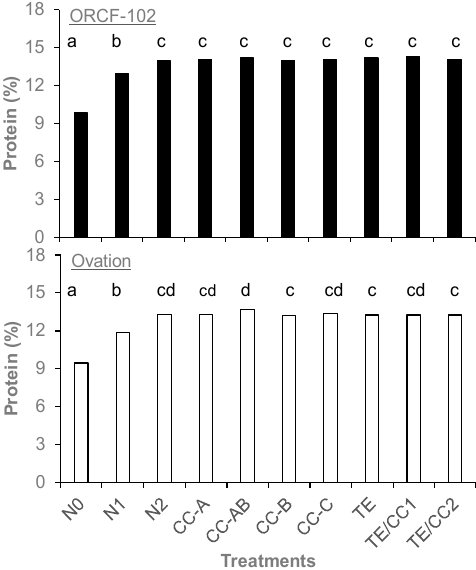
Figure 3. The protein content (%) of two winter wheat varieties among the treatments across the data of two years in Adkins fine sandy loam soil. N0 = no fertilization; N1 = normal N rate; N2 = high-N rate without PGR application; CC-A = applying CC at GS30-32; CC-AB = applying CC at GS30-32 and GS37-39; CC-B = applying CC at GS37-39; CC-C = applying CC at GS21-26; TE = applying TE at GS30-32; TE/CC1 = applying TE at GS30-32 and applying CC (0.442 L ha − 1 a.i.) at GS37-39; TE/CC2 = applying TE at GS30-32 and applying CC (1.004 L ha − 1 a.i.) at GS37-39. Di ff erent letters on the top of each column indicate significant di ff erences among treatments at 5% level according to LSD